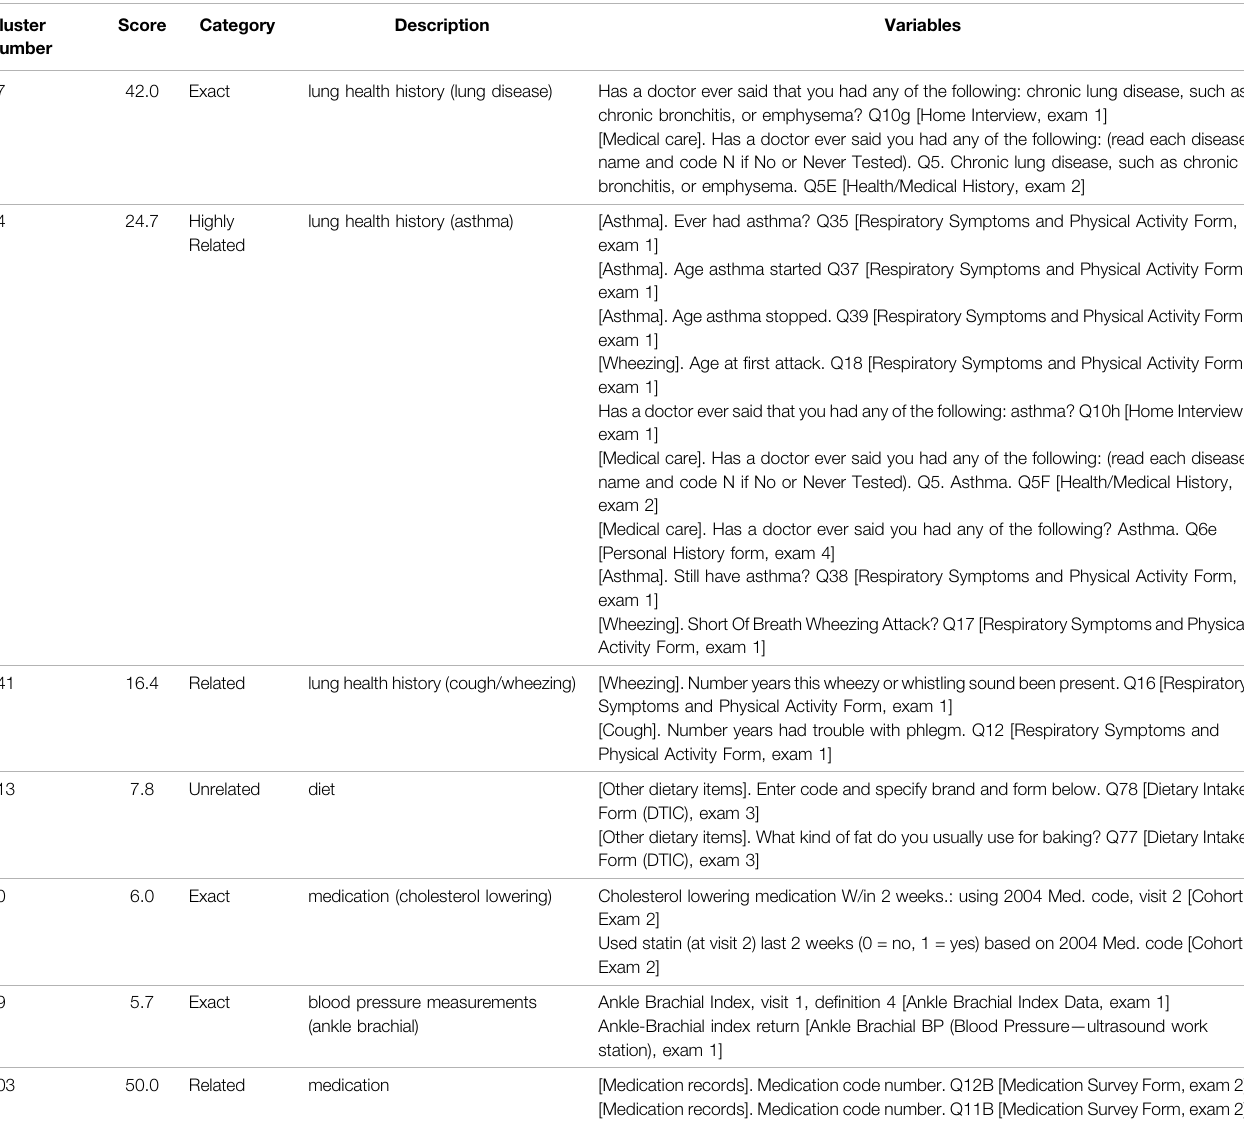
TABLE 2 | Examples of clusters which both re fl ect (67, 14, 341, 213) and do not re fl ect (70, 49, 403) their programmatically generated scores. The table includes a cluster identi fi er (Cluster Number), calculated relatedness score from the NLP analysis (Score), relatedness category from manual review (Category), description of the overarching theme of the cluster (Description), and the ARIC variables in the cluster (Variables). Clusters were selected to highlight cases of agreement and disagreement between programmatic scoring and reviewer category assignment. See Supplemental Table S1 for all